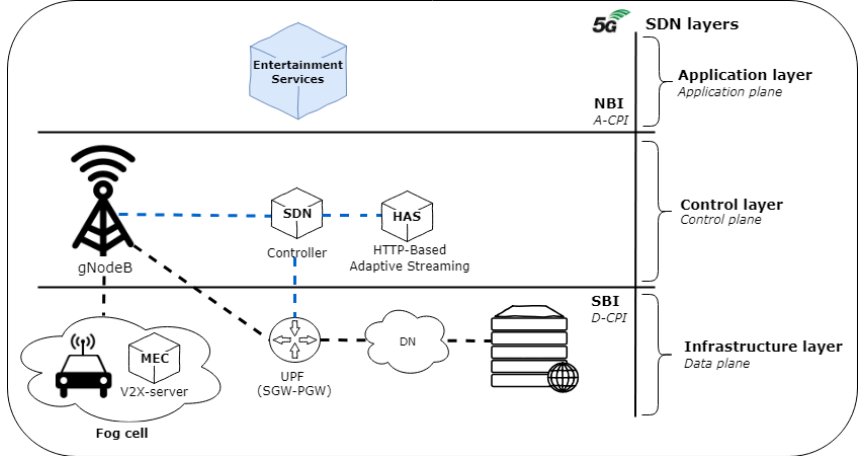
Figure 4. Logical view of SDIoV entertainment